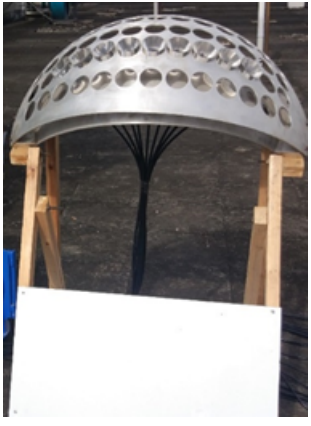
Figure 12. Fixed light guide system.